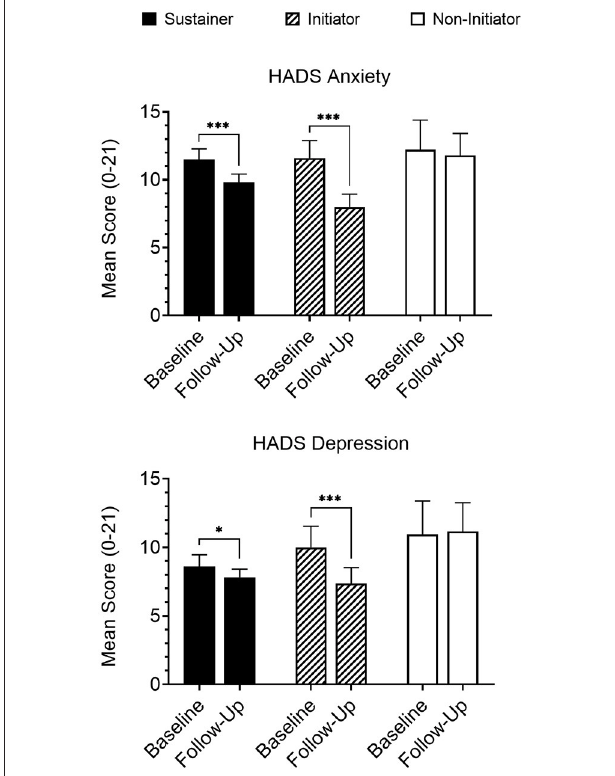
FIGURE 2 | Participants that either initiated medicinal cannabis use (“Initiators”; n = 36) or continued cannabis use that had been reported at baseline (“Sustainers”; n = 121) reported significantly reduced anxiety and depression on the HADS at follow-up, while participants that did not initiate cannabis use (“Non-initiators”; n = 23) reported no change. Follow-up data presented are collapsed across all completed follow-up assessments for members of each group. * p < 0.05; *** p <